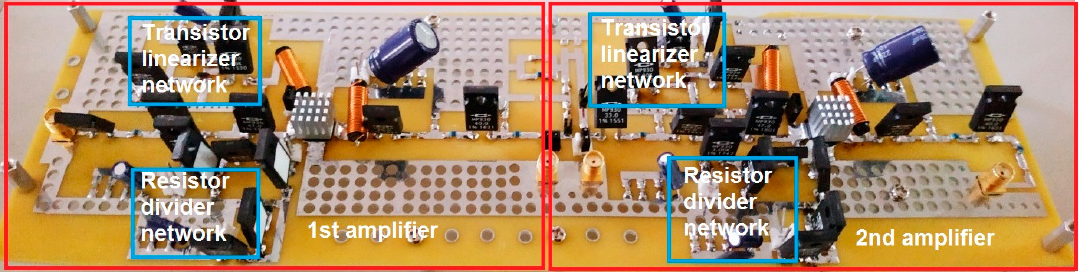
Figure 2. Photo of the class-C amplifiers with resistor divider network and transistor linearizer network.